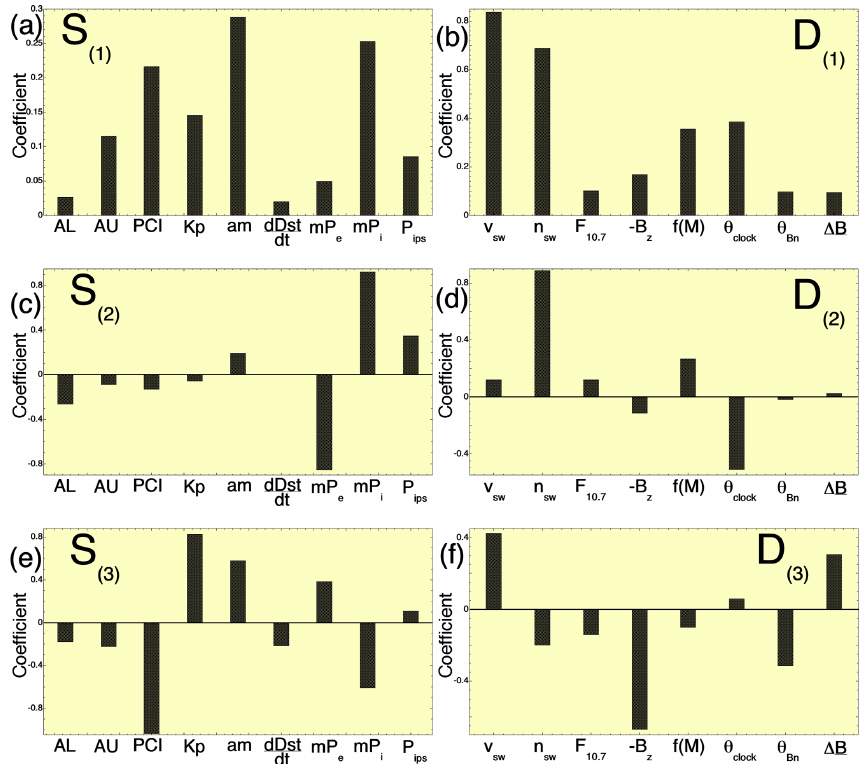
Figure 2. Plots of the nine components of the coefficient vectors used to project the system state vector S into the aggregate variables S ( 1 ) (a) , S ( 2 ) (c) , and S ( 3 ) (e) and plots of the eight components of the coefficient vectors used to project the driver state vector D into the driver scalar variables D ( 1 ) (b) , D ( 2 ) (d) , and D ( 3 ) (f) .